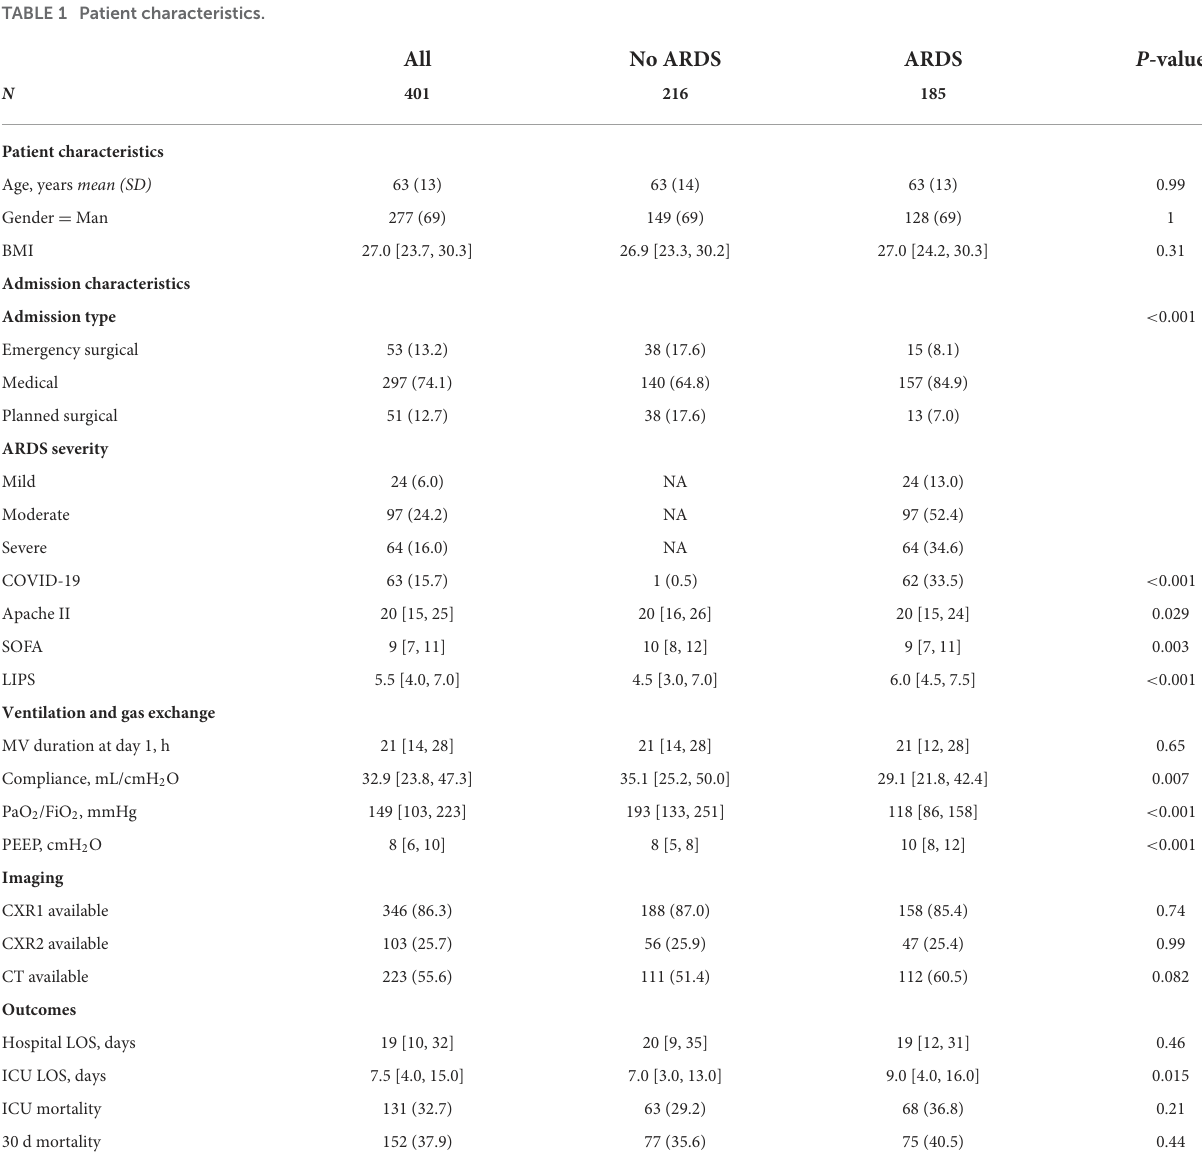
TABLE 1 Patient